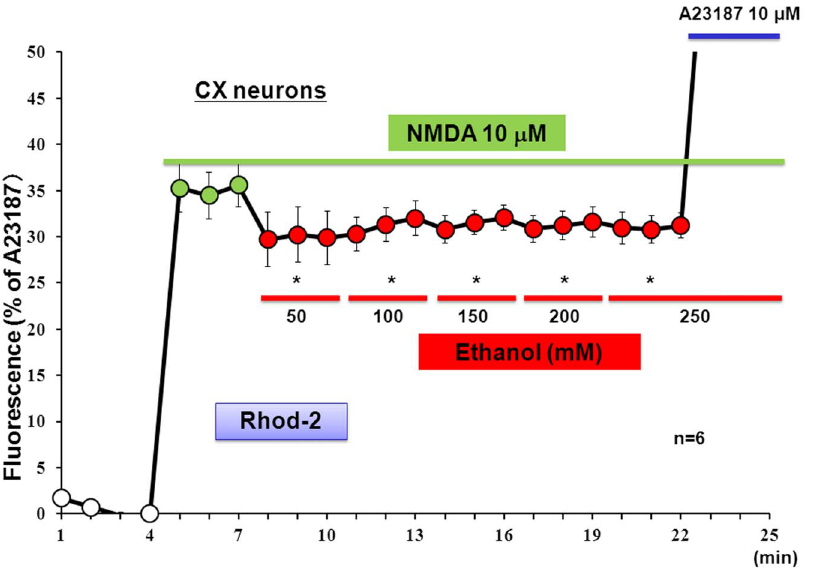
Figure 2. Effects of ethanol at different concentrations on Rhod-2 fluorescence in cultured neurons. Murine neocortical neurons were cultured for 8 days, followed by loading of Rhod-2 and subsequent cumulative addition of ethanol at different concentrations 3 min after the addition of 10 m M NMDA. Values are percentages over the maximal fluorescence by A23187 in 3 independent determinations. # P , 0.05, significantly different from the control value obtained in cells before the addition of ethanol. Statistical significance was determined according to the Students’ t - testanalysis.